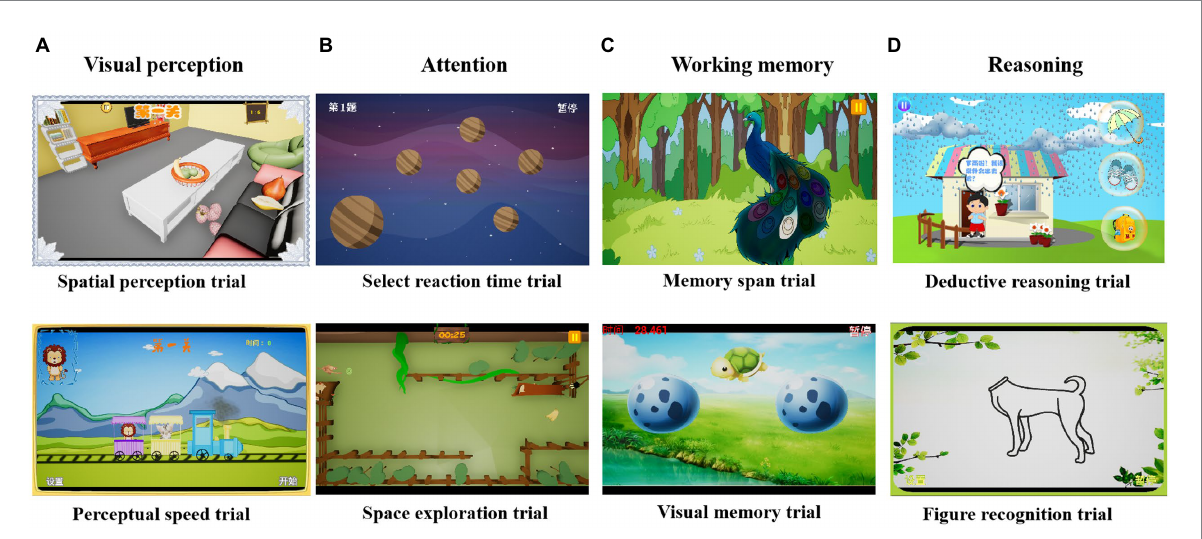
FIGURE 1 The eight trials of computerized cognitive training. (A) Visual perception block, including the spatial perception and perceptual speed trials. (B) Attention block, including the select reaction time trial and space exploration trial. (C) Working memory block, including the memory span trial and visual memory trial. (D) Reasoning block, including the deductive reasoning and figure recognition